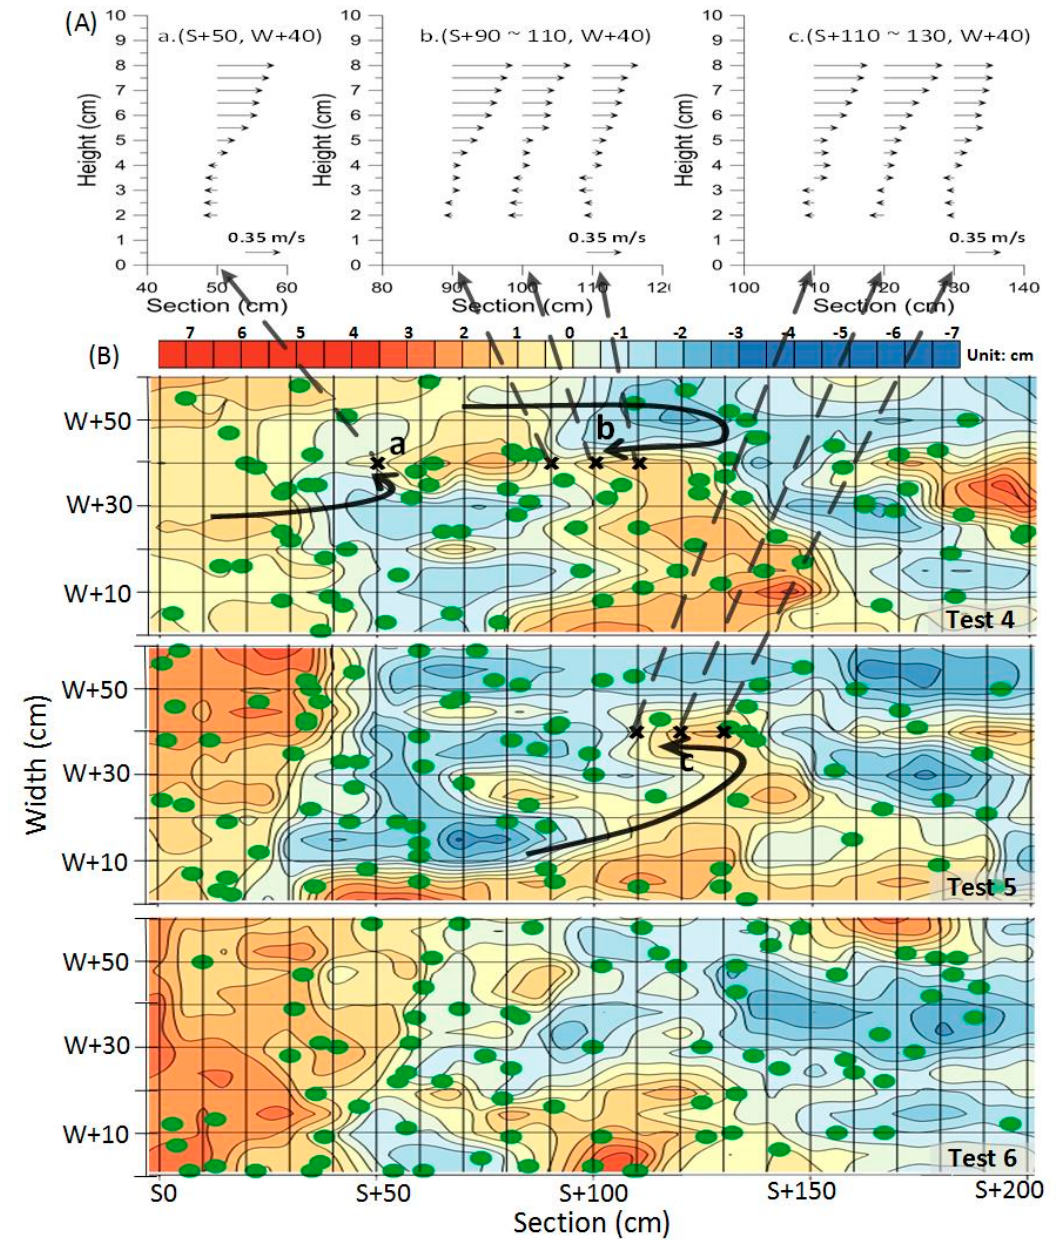
Figure 4. ( A ) The vertical velocity profile of backwaters at measuring points a (S+50, W+40), b (S+90 to 110, W+40), c (S+110 to 130, W+40). ( B ) The contour map of channel topography after the 66.67 stems/m 2 experiments (test 4–6). Green dots represent vegetation.